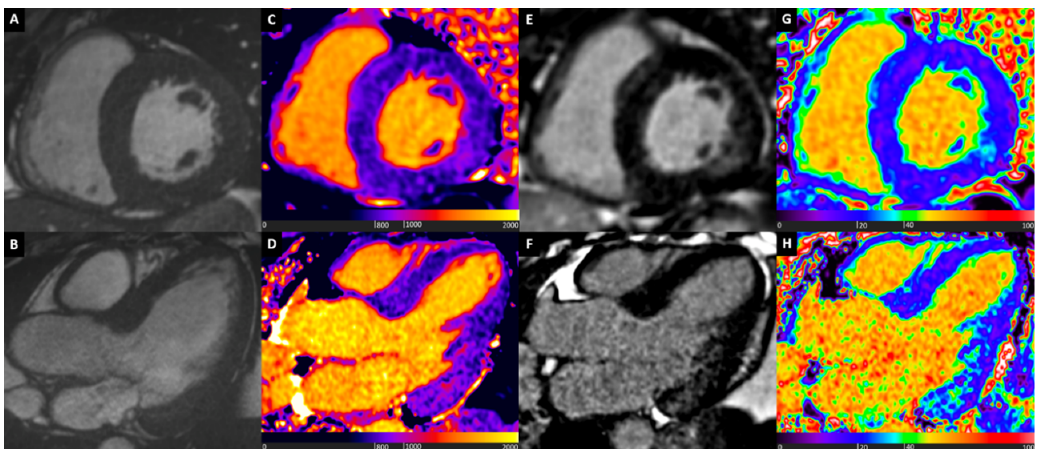
Figure 6. Fabry cardiomyopathy. Basal short axis (top row) and 3-chamber long axis (bottom row) cardiovascular magnetic resonance (CMR) images of a patient with Anderson–Fabry cardiomyopathy showing mild ventricular hypertrophy (Boxes A and B ), low global native T1 values with normalized values at the basal inferolateral wall (Boxes C and D ), mid-wall late gadolinium enhancement at the basal inferolateral wall (Boxes E and F ), with matching high ECV values at basal inferolateral wall (Boxes G and H ).